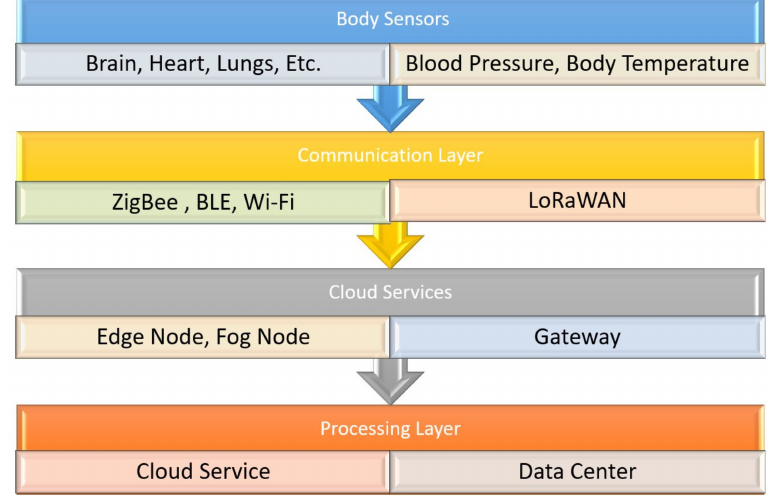
Figure 3. A brief overview of IoT-assisted wearable sensor systems for healthcare monitoring.